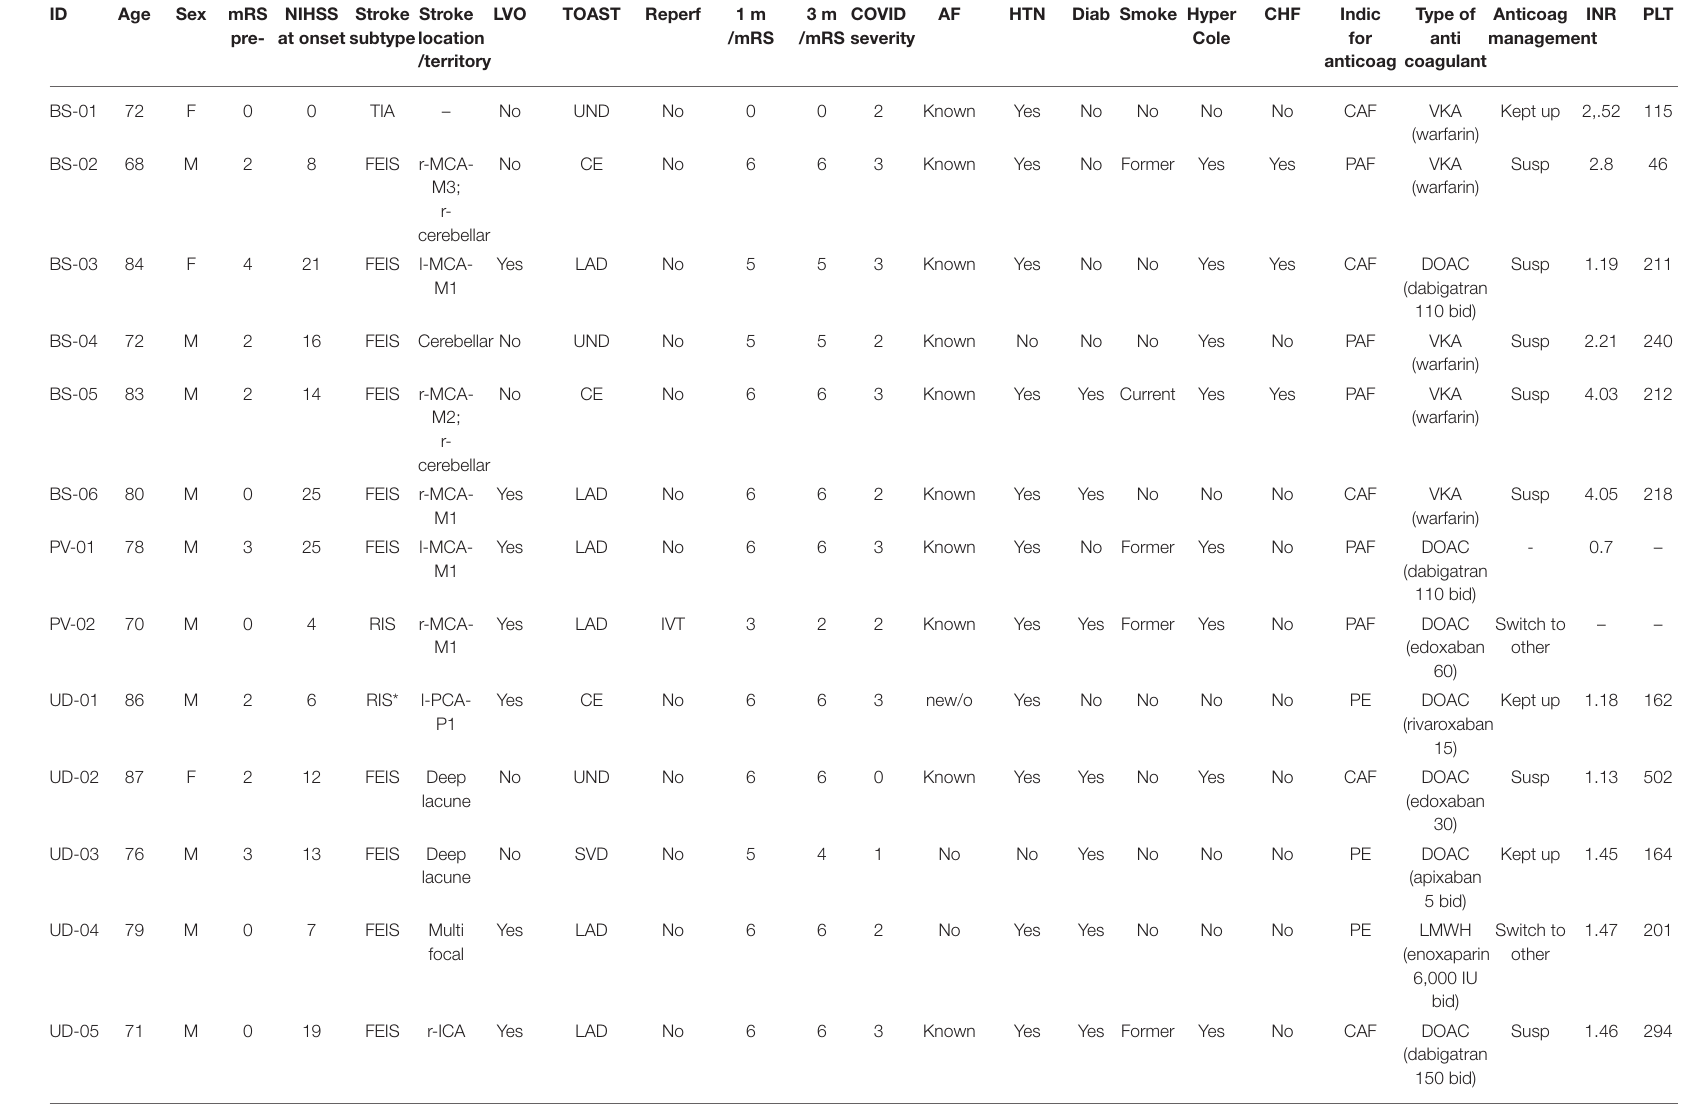
TABLE 1 | Clinical characteristics, risk factors, and outcomes of COVID19-related acute ischemic strokes (AISs) under therapeutic anticoagulation. ID